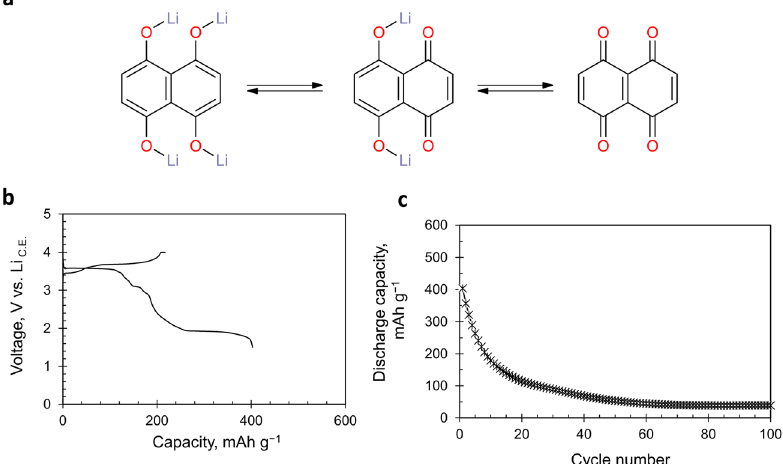
Fig. 4 Battery performance of the electrode using the naphthazarin monomer 1. a , Conceivable charge/discharge reaction of 1 . b , c Charge/discharge curves ( b ) and cycle-performance ( c ) of the electrode of 1 . (Current density: 20 mA g − 1 , Temperature: 30 form). The lower voltage region around 2 V vs. Li C.E. corresponds to show a four-electron transfer type redox reaction (Fig. 4a), which can lead to a high capacity. Figure 4b shows the initial to the further reduction in which the tetra-hydroxy-naphthalene- charge and the following discharge curves of the electrode com- tetra-lithium salt (shown in the left side of Fig. 4a) is supposed to posed of 1 . Since this molecule is in a half-charged state (i.e., the be formed. The observed capacity of 403 mAh g − 1 accounts for 76% of the theoretical one, 531 mAh g − 1 , based on the assumed State of Charge (SOC): 50%) at the pristine state, the capacity four-electron redox reaction per molecule. The average discharge observed during the fi rst charge process corresponds to half of its voltage of 2.65 V vs. Li C.E. is close to that for the benzoquinone full capacity. The following fi rst discharge curve can be roughly derivatives 16 . This initial behavior implies that the naphthazarin divided in two voltage regions. The higher voltage region around skeleton has the potential to work as a high capacity redox unit. 3.5 vs. Li C.E. re fl ects the reduction (cathodic) reaction of the diquinone (the lithium-free derivative shown on the right side of Nevertheless, its cycle stability was poor; namely, as shown in the redox scheme in Fig. 4a) which should be formed during the Fig. 4c, the discharge capacity quickly began to drop after the fi rst charge process of the naphthazarin lithium salt 1 (dilithium second cycle to eventually decay to 39 mAh g − 1 after 100 cycles.